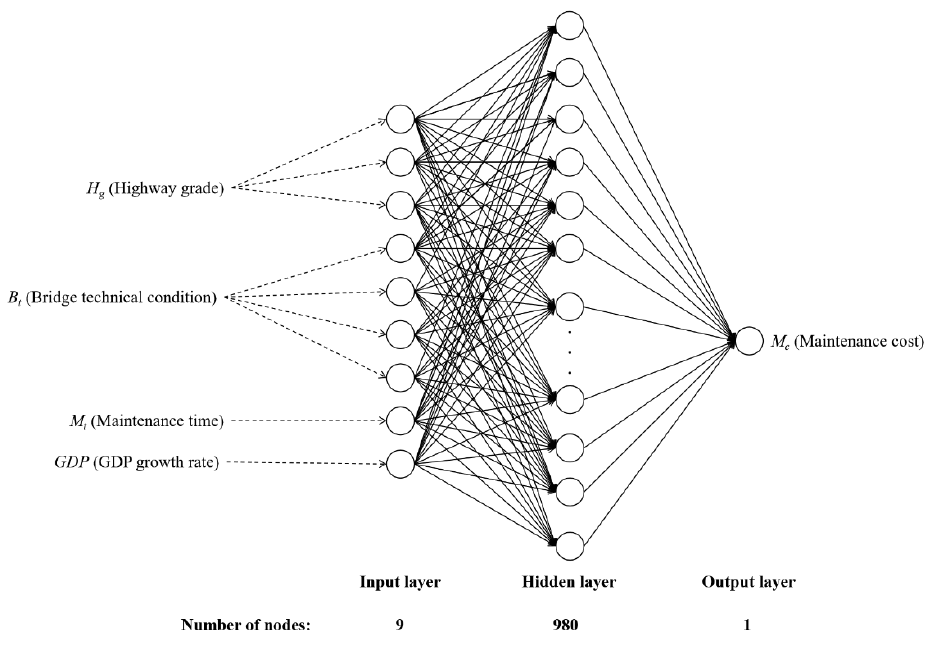
Figure 11. Topology of the fully-connected ANN prediction model.